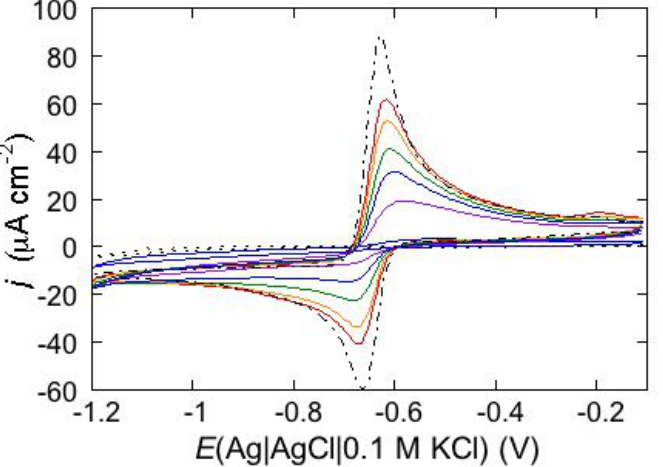
in a pH 7 aqueous solution of 0.1 M Figure 15. Cyclic voltammograms of 0.20 mM CdSO 4 KCl and of 0.6 μ M AmB mixed with Chol in a (1:3) molar ratio, as recorded at a DPTL/DOPC tBLM during continuous potential cycling at a scan rate of 50 mV s − 1 . The before the AmB/Chol mixture. Increasing peak curves were obtained upon adding CdSO 4 currents correspond to an increasing number of potential cycles. The flat dotted curve was obtained in the absence of the AmB/Chol mixture; the dash-point curve was obtained at a newly formed uncoated mercury drop immersed in a solution of 0.1 M KCl and 0.20 mM CdSO containing the AmB/Chol 4